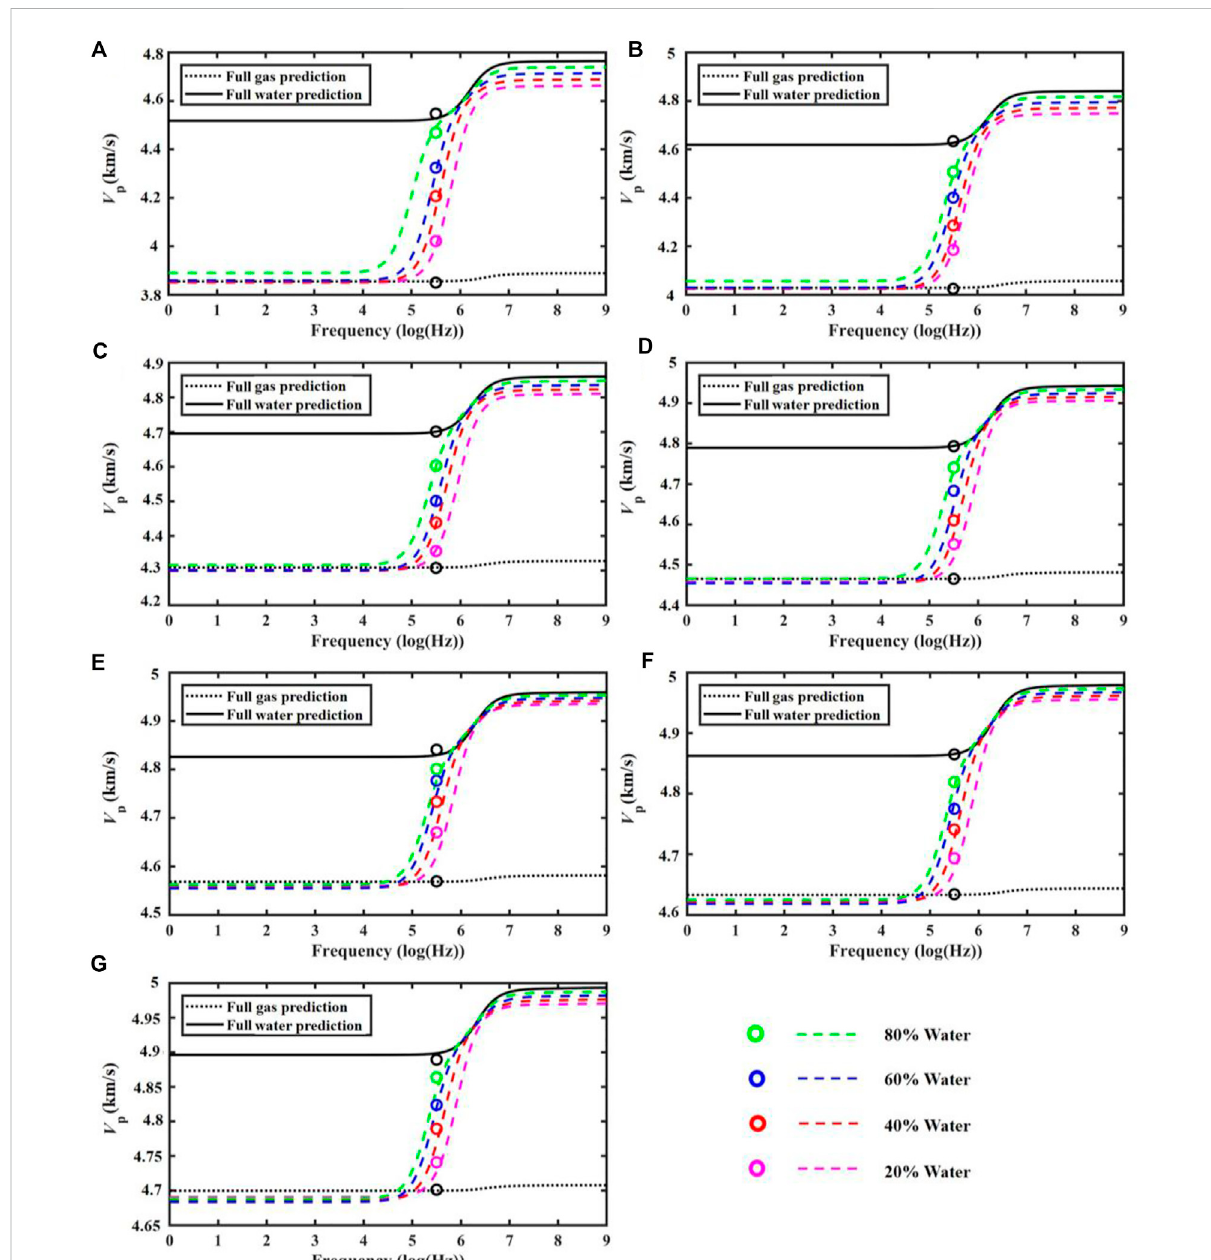
FIGURE 10 P-wave velocity frequency dependence for sample 1 – 19 at 5 MPa (A) , 10 MPa (B) , 20 MPa (C) , 30 MPa (D) , 40 MPa (E) , 50 MPa (F) and 60 MPa (G) . The experimental data are shown as